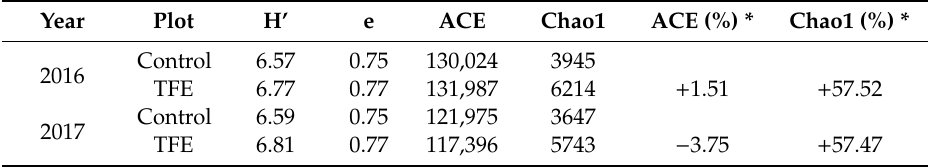
Table 5. Comparison between control and TFE plots with diversity, evenness, and richness of microbes over the TFE experiment. H’ = Shannon–Weaver Diversity Index values; e = species evenness; ACE = abundance-based coverage estimator index; Chao1 = richness index.